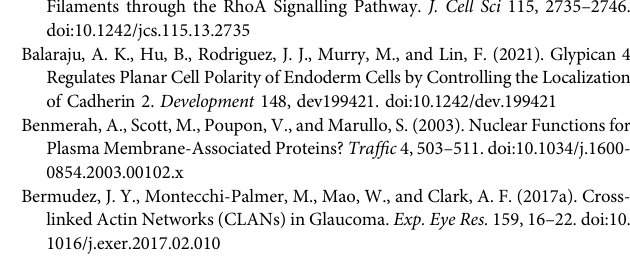
compared to control cells. Scale bars indicate image magni fi